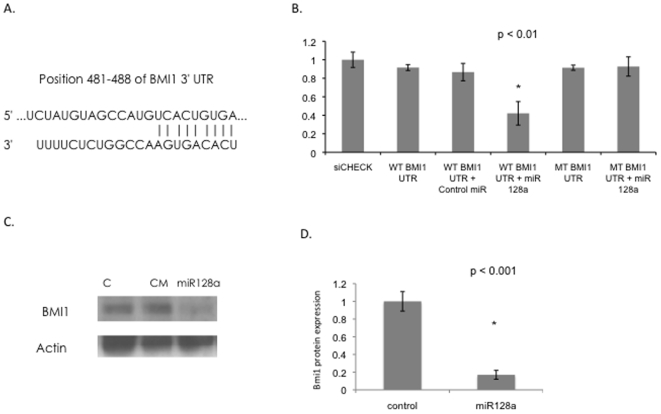
Transfection of Daoy cells with miR-128a decreases Bmi-1 expression.A) MiR-128a target site in the Bmi-1 3′UTR. B) Luciferase reporter assays indicate that miR-128a functionally targets the wt Bmi-1 3′UTR, *p<0.01 C) Western blot analysis confirms that miR-128a, but not the control miR (CM), inhibits protein expression of Bmi-1 in medulloblastoma cells. D) Quantitation of Western blot bands. (p<0.01)